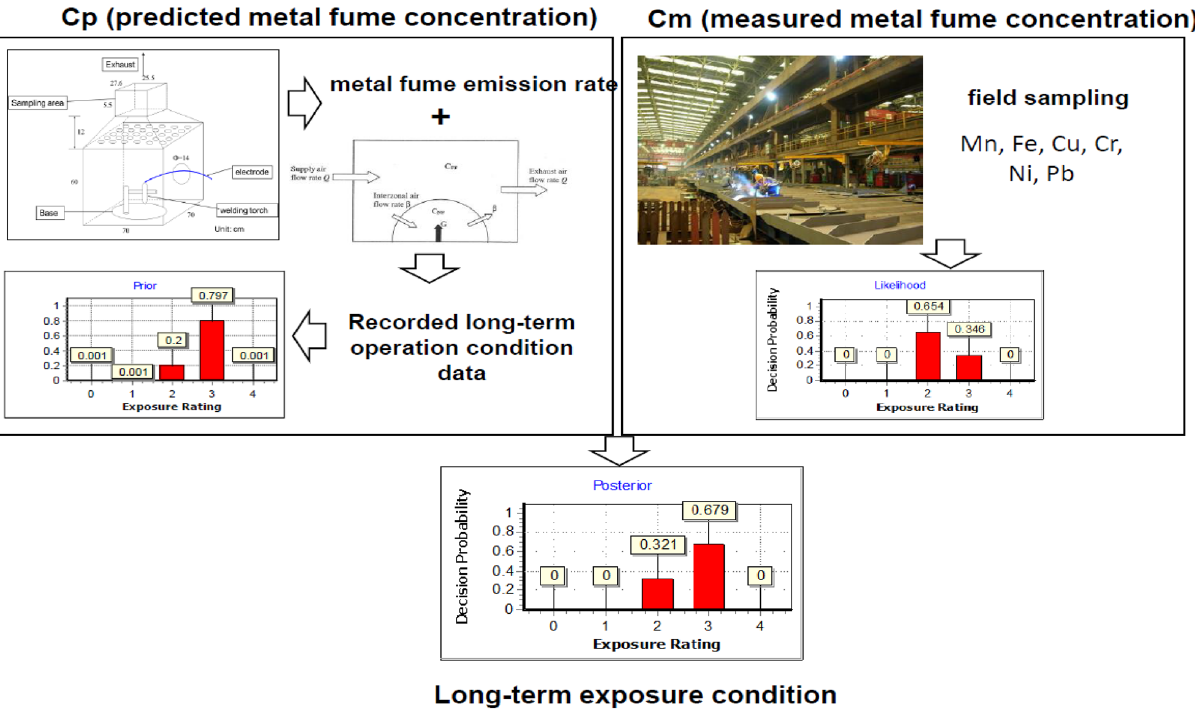
Figure 1. Graphic abstract of the research structure of this